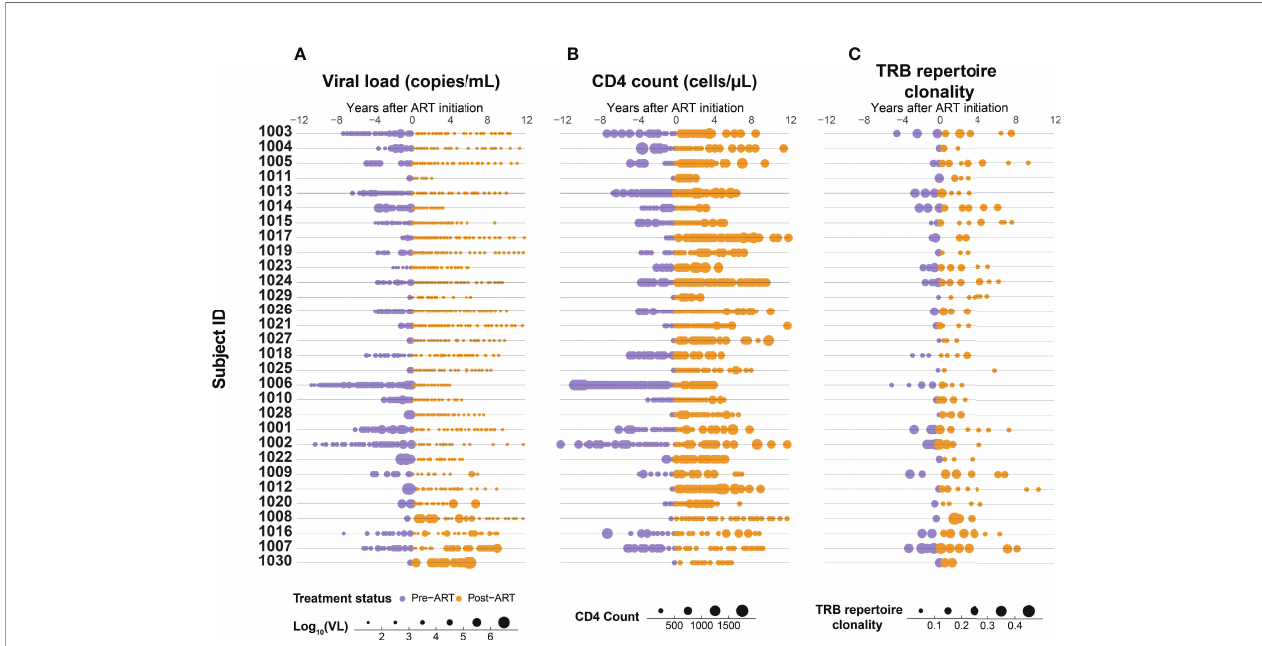
FIGURE 1 | Suppression of HIV replication with ART is associated with a gradual increase in CD4 + T-cell count and decrease in T-cell b -chain repertoire clonality. Serial measurements of (A) HIV viral load, (B) CD4 + T-cell count, and (C) clonality of the peripheral blood TRB repertoire in 30 adults with HIV infection determined up to 12 years before (purple) and after (orange) ART